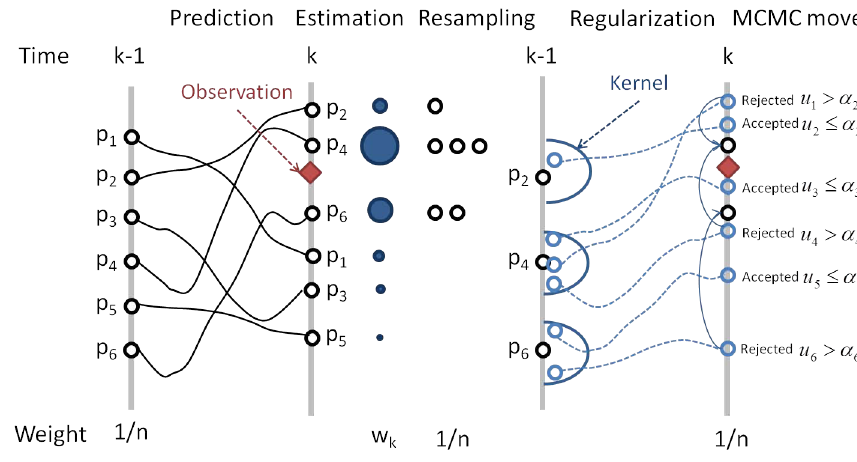
Fig. 2. A single cycle of a regularized particle filter.